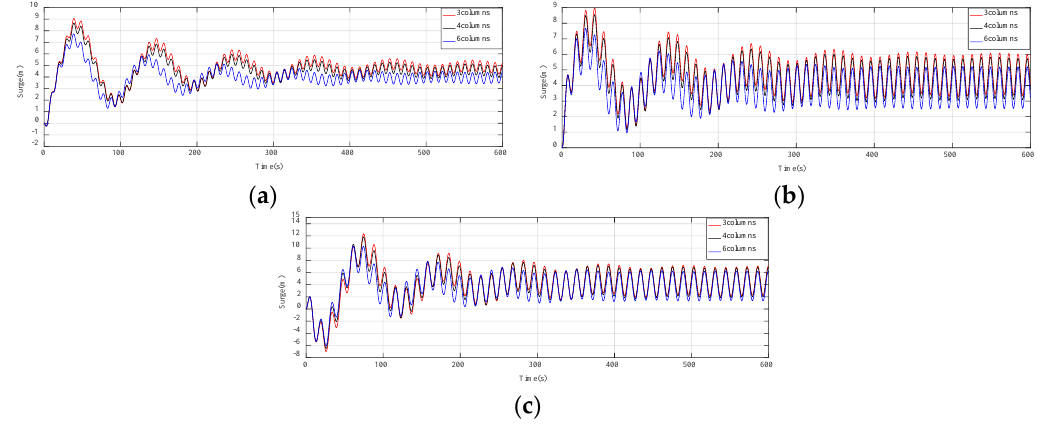
Figure 9. Surge response for all three platforms under wave loadings ( a ) LC1, ( b ) LC2, and ( c ) LC3.